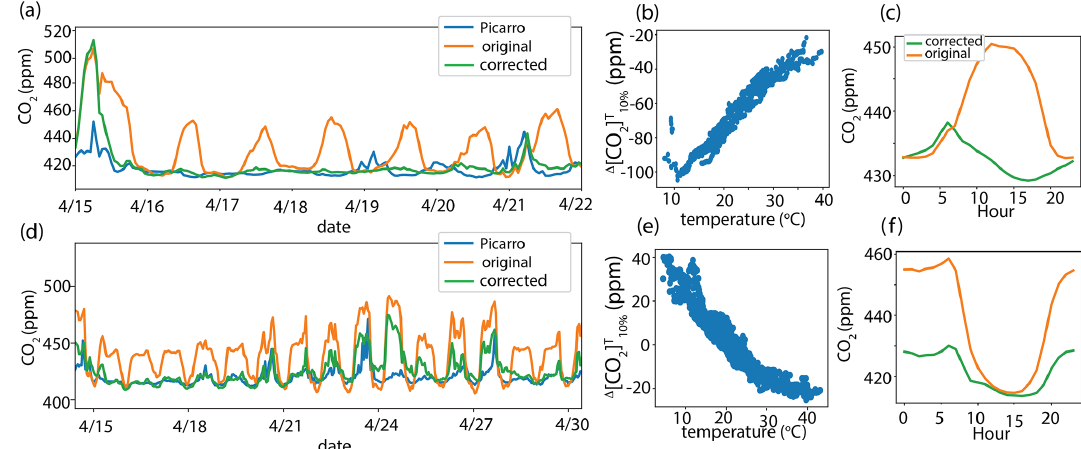
Figure 5. CO 2 mixing ratios at (a) EBMUD and (d) Montclair with no temperature correction (orange), temperature correction applied (green), and measured with a Picarro instrument at the Richmond Field Station supersite (blue). Temperature dependence of (cid:49) [ CO 2 ] T (b) EBMUD and (e) Montclair. Diurnal cycle with and without temperature correction at (c) EBMUD and (f) Montclair.